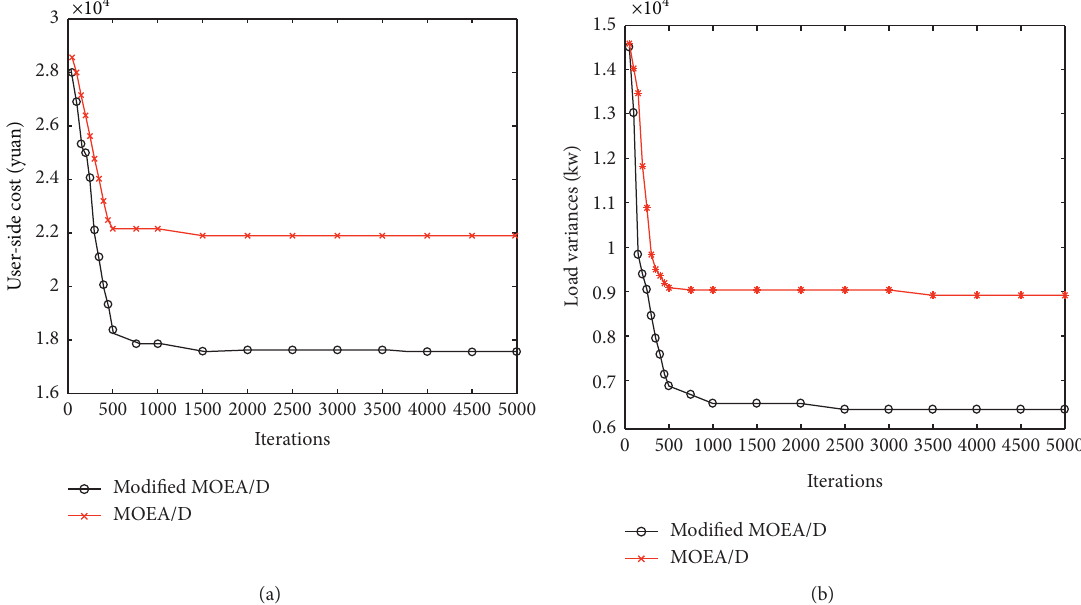
Figure 12: Comparison of convergence. (a) The curve of the value of the user-side cost. (b) The curve of the value of load variances.